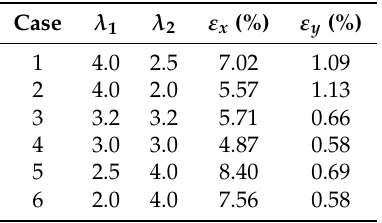
Table 3. The actuation strains with different prestretches for θ = 90 ◦ , Φ = 7.5